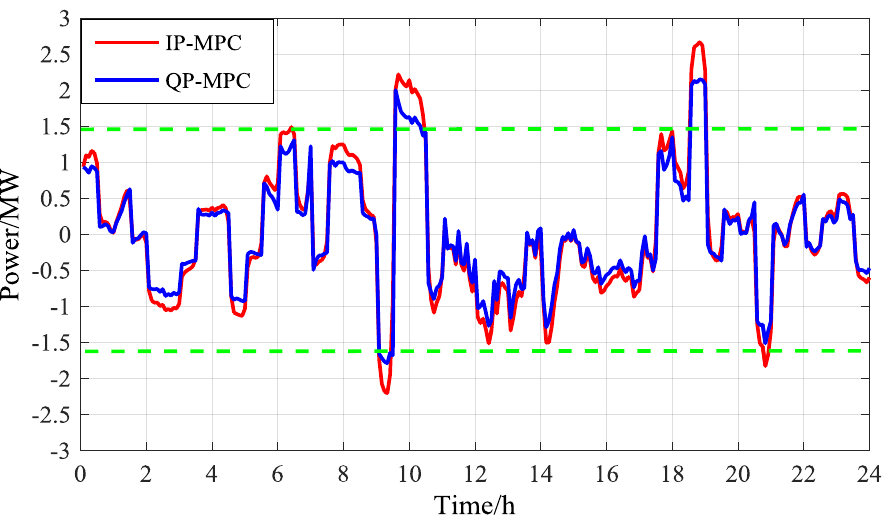
Figure12. Power response of BESS (9 MWh).